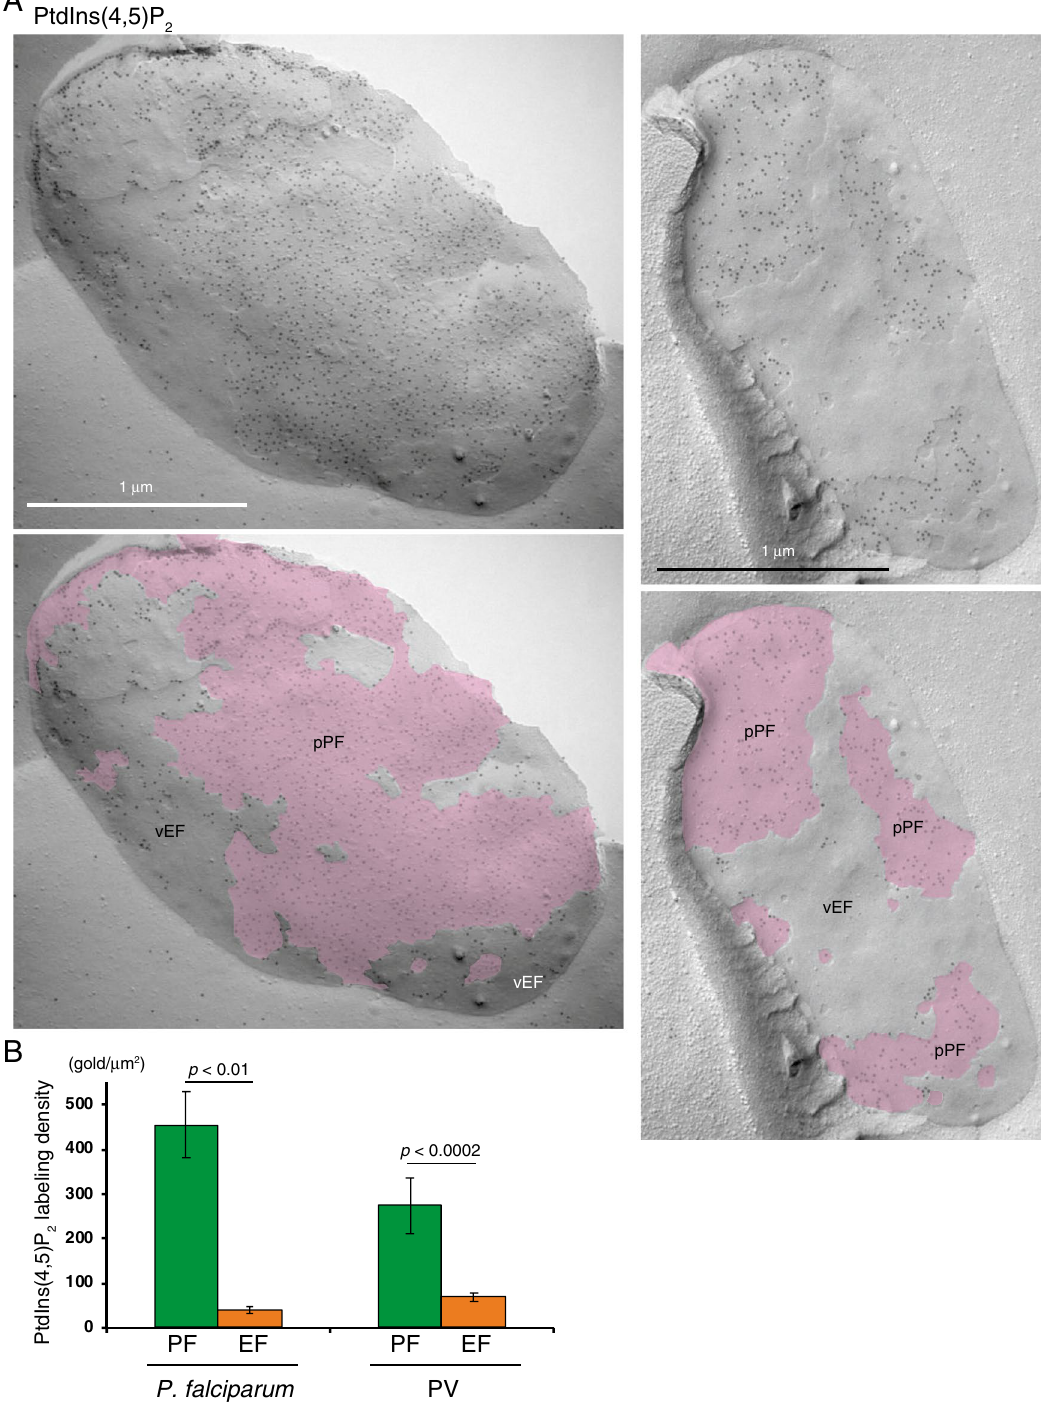
Figure 4. Localization of the PtdIns(4,5)P 2 labeling on the PF of the P. falciparum plasma membrane and PV membrane. ( A ) The labeling of PtdIns(4,5)P 2 was mainly observed on the PF in both the P. falciparum plasma membrane (pPF, pink) and PV membrane (vPF), although it was faintly identified on the EFs (vEF) of both membranes. Scale bars: 1 μm. ( B ) Labeling density of PtdIns(4,5)P 2 in each leaflet of the P. falciparum plasma membrane and PV membrane. The labeling densities of PtdIns(4,5)P 2 on the PF (green) and the EF (orange) of the P. falciparum plasma membrane and PV membrane are shown. The significantly higher gold labeling densities on the PF of both the P. falciparum plasma membrane and PV membrane were detected. Mean ± s.e.m. of three independent experiments is shown. The labeling densities of GM3 on the PF were significantly (Student’s t -test) and much higher than that on the EF of both the P. falciparum plasma membrane and PV